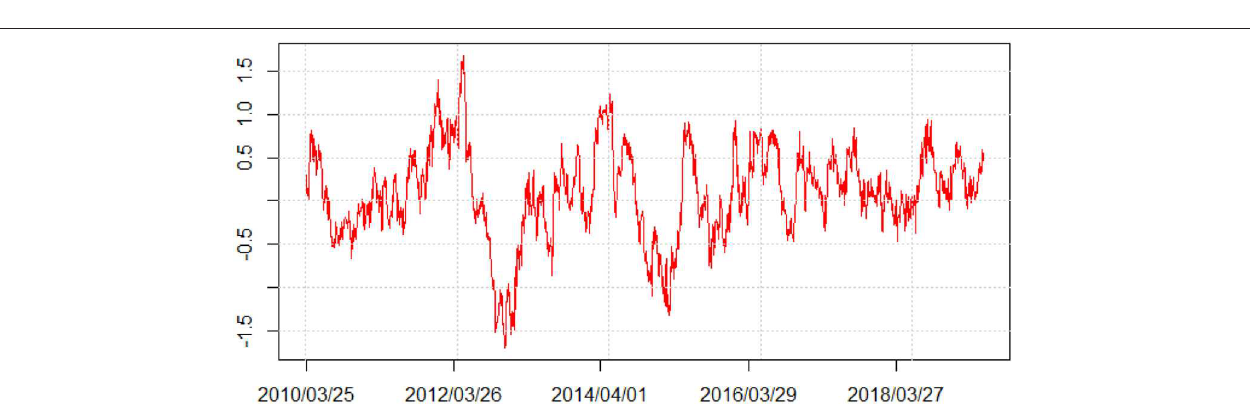
FIGURE 6 | Net volatility spillovers from West Texas intermediate (WTI) to China’s bulk commodity